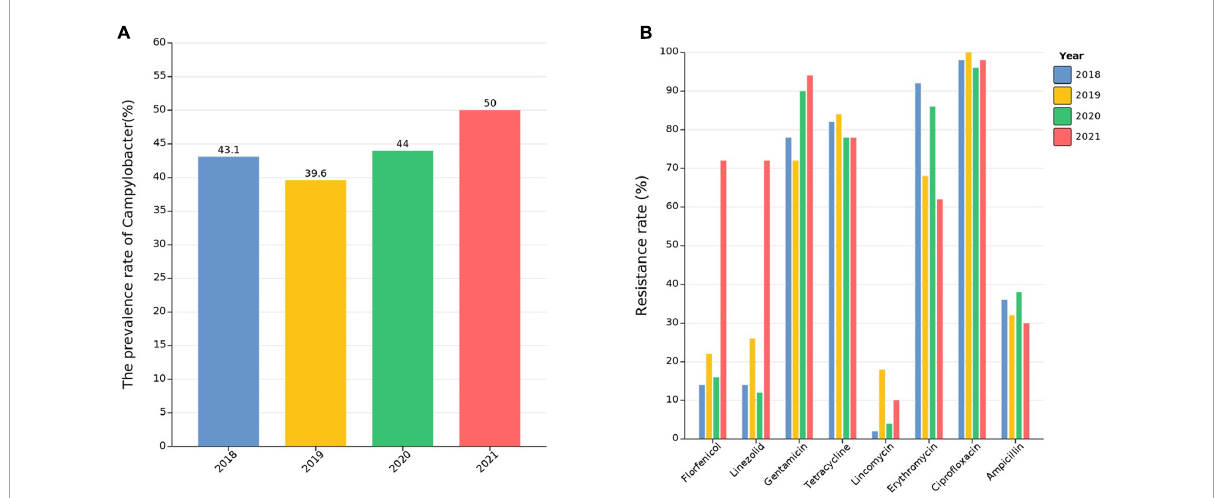
FIGURE1 The prevalence and antibiotic resistance rate in Campylobacter isolates. (A) The prevalence rate of Campylobacter over 4 years. (B) Antibiotic resistance rates of isolated Campylobacter spp. as determined by antibiotic susceptibility